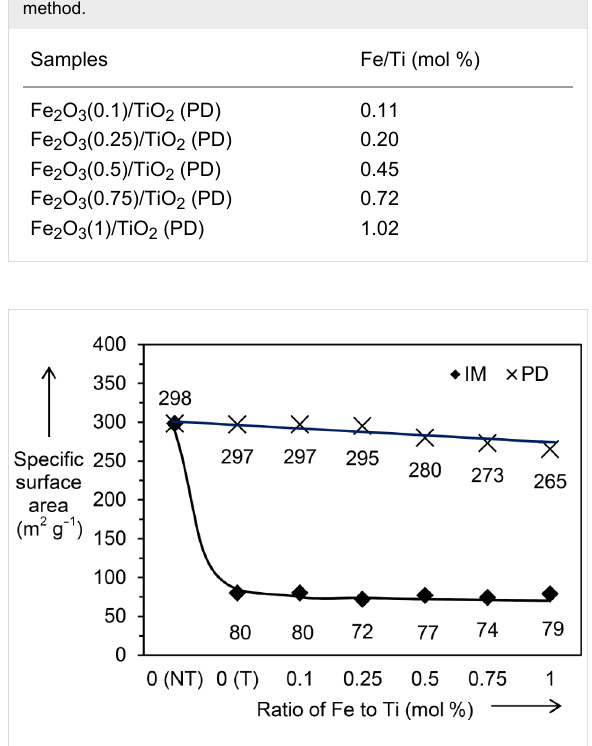
Figure 3: BET specific surface area of TiO 2 (NT), TiO 2 (T) and the series of Fe 2 O 3 /TiO 2 samples prepared by both impregnation (IM) and photodeposition (PD). NT represents no treatment and T indicates an additional heat treatment or photodeposition treatment was carried out on the